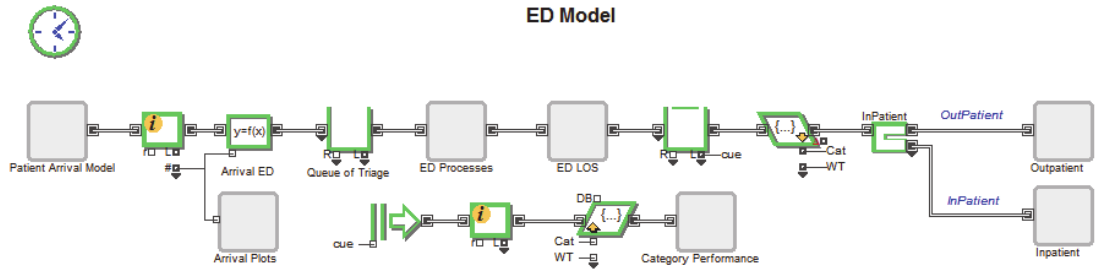
Fig. 6. ExtendSim model of the patient flow in the